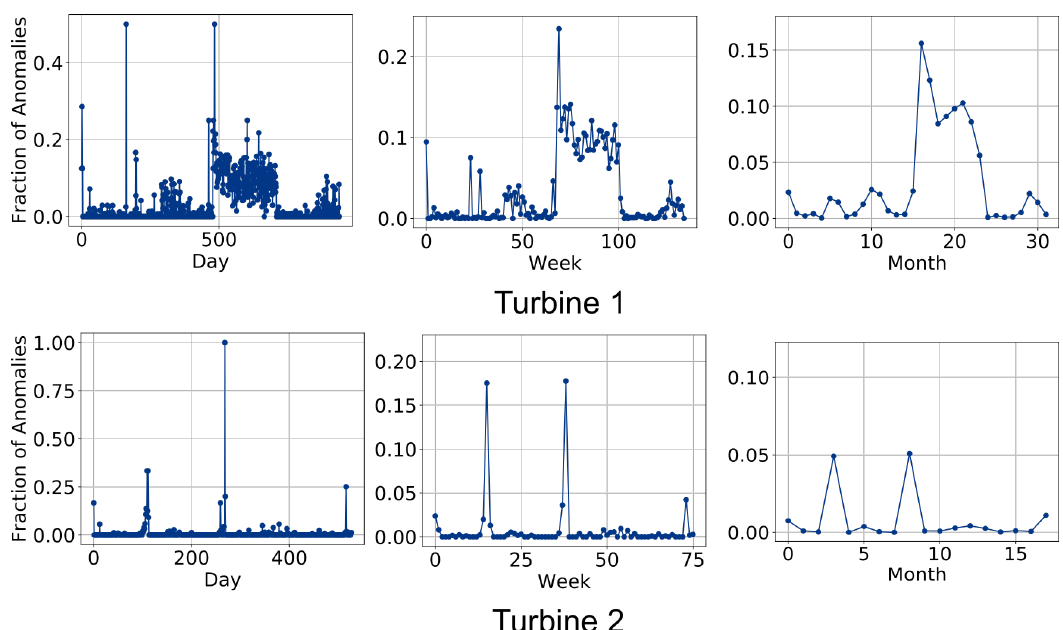
Figure 6. Comparison of post-processing window length for turbines 1 and 2. Results taken from models trained on 6 months of data